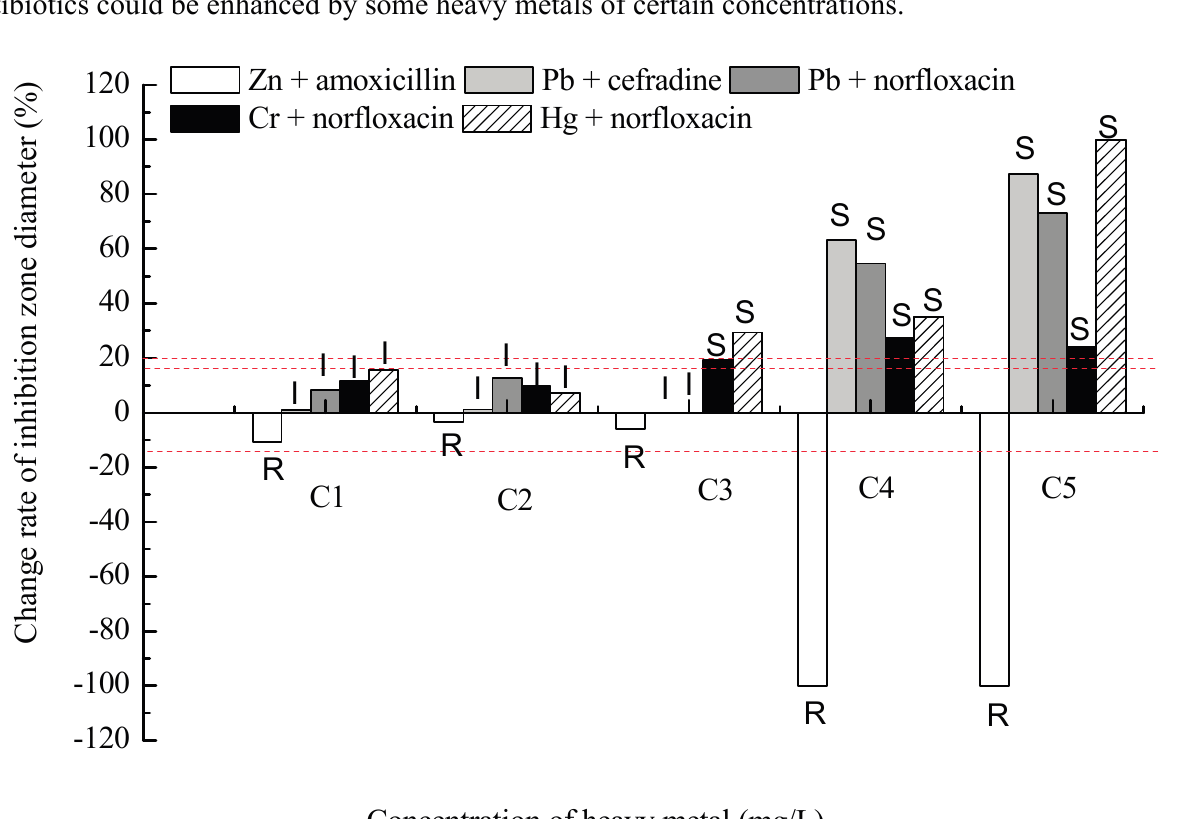
Figure 3. Effect of heavy metals on antibiotic resistance unchanged with heavy metal concentration. Some histograms cannot be seen since the inhibition zone size of some antibiotics are unaffected by certain concentrations of some heavy metals. R (Resistant), I (Intermediate) and S (Sensitive) of the CLSI category were labeled on each column. C1, C2, C3, C4, C5 were the effective concentrations of each heavy metal in the medium, that is, Pb 2+ of 0.06, 1.66, 9.25, 49.37, 98.02 mg/L, Cu 2+ of 0.07, 1.66, 9.96, 46.17, 98.68 mg/L, Zn 2+ of 0.07, 1.78, 8.97, 44.96, 90.34 mg/L, Cr 6+ of 0.06, 1.88, 19.18, 46.70, 77.59 mg/L, and Hg 2+ of 0.07, 0.86, 4.96, 9.24, 19.38 mg/L, respectively. The red lines are the critical values of change rates, which are counted according to the CLSI category shown in Table 1, and the symbols of “R”, “I” or “S” are also the results of the comparison between the change rate and the critical value of the same